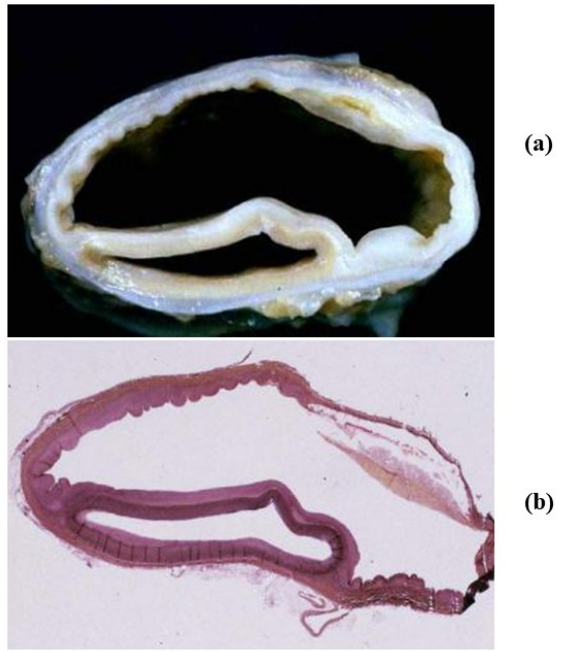
Figure 21. Double barrel aorta in chronic aortic dissection. ( a ) Gross view. ( b ) Corresponding histology. (Weigert Van Gieson stain).